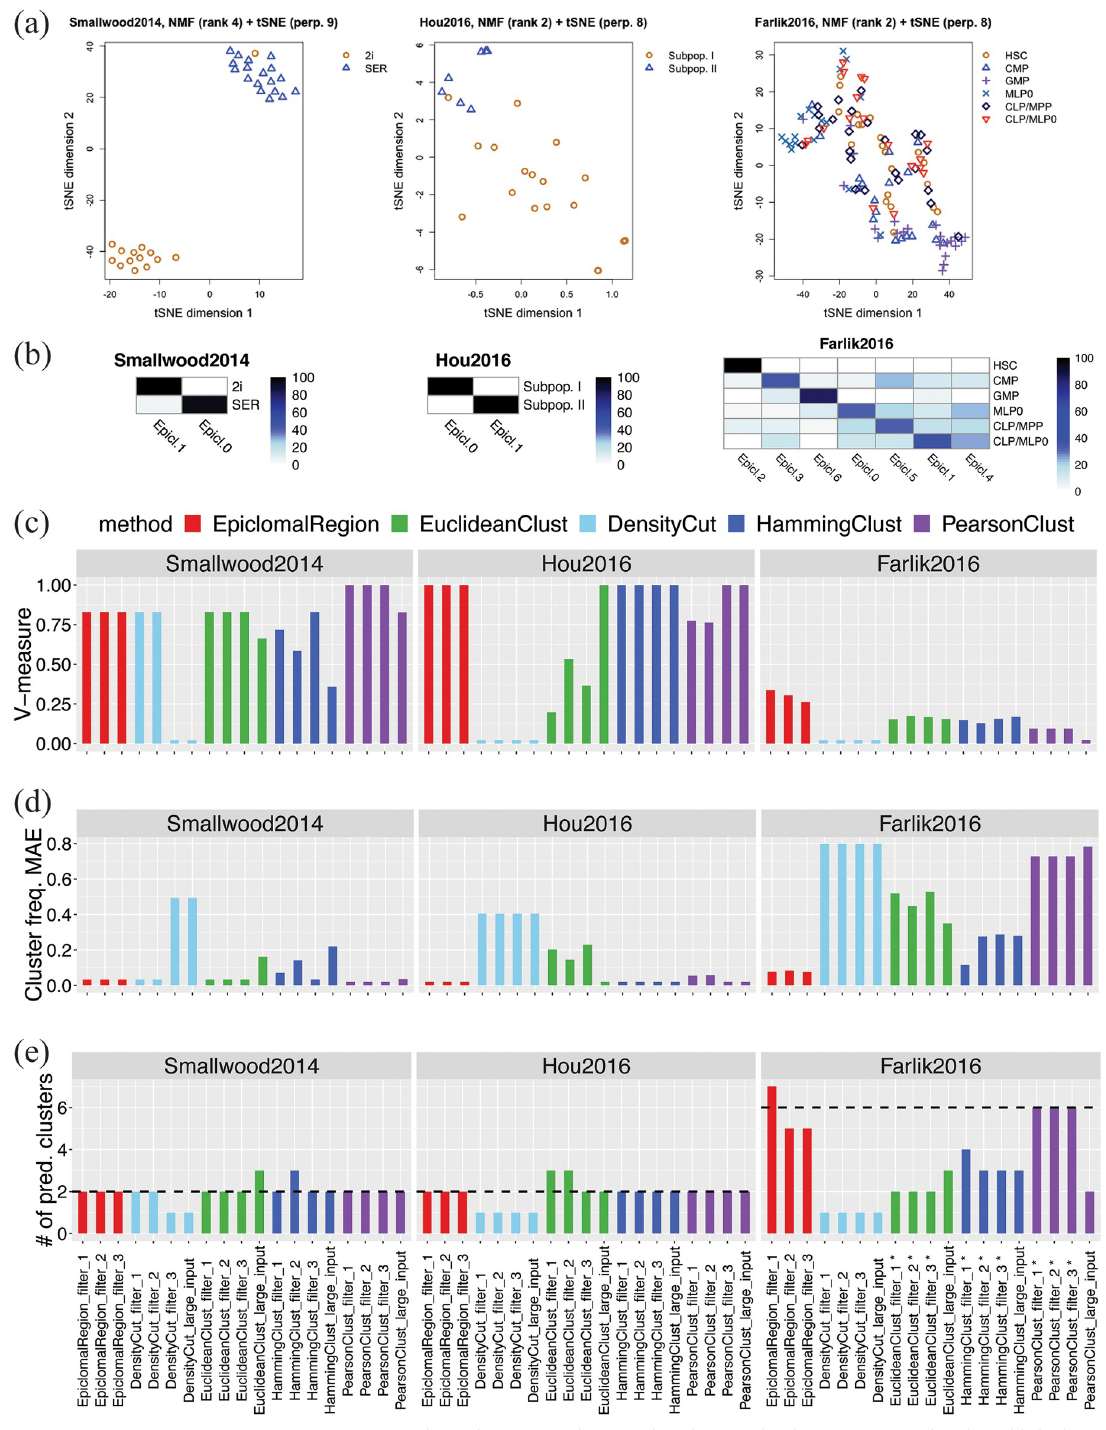
Fig 6. Results on the real data sets. (a) Dimensionality reduction visualization plots showing the clustering reported in the published papers on the � 10,000 loci processed data sets. (b) Co-clustering between the real data published clusters on the rows and EpiclomalRegion predictions on the columns. Each entry a is the percentage of cells in published class i that are present in predicted ij cluster j , with the rows summing up to 100%. A perfect agreement would result in a square matrix with a black diagonal. (c) V-measures comparing the cell assignments with the published assignments, with higher values meaning better agreement. (d) Cluster frequencies mean absolute error, comparing the inferred proportions of clusters with the published proportions, with lower values meaning better